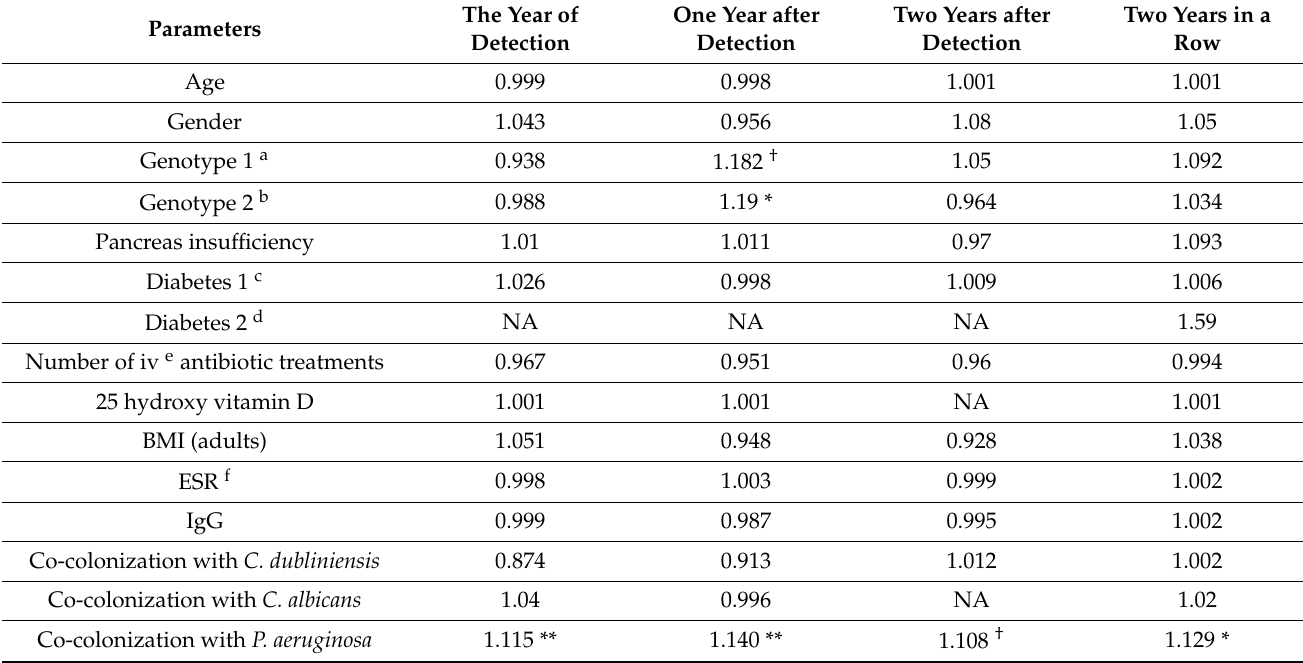
Table 4. The odds ratio of parameters that may predict the impact of A. fumigatus on lung function. The Year of One Year after Two Years after Two Years in a Parameters Detection Detection Detection Row Age 0.999 0.998 1.001 1.001 Gender 1.043